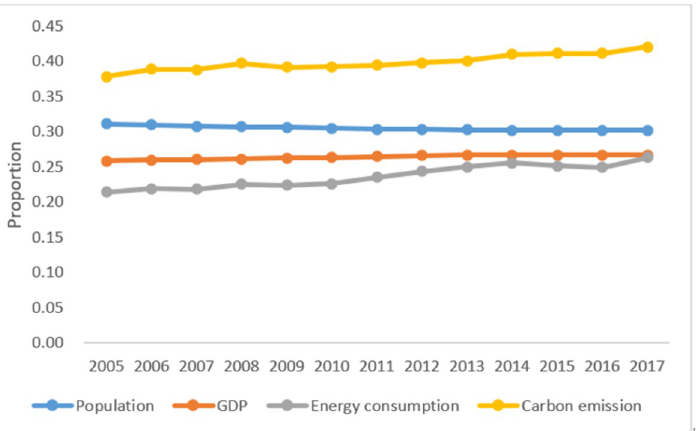
Fig 2. The proportion of the YRB to China. (Data sources: Calculated according to the China Statistical Yearbook from 2006 to